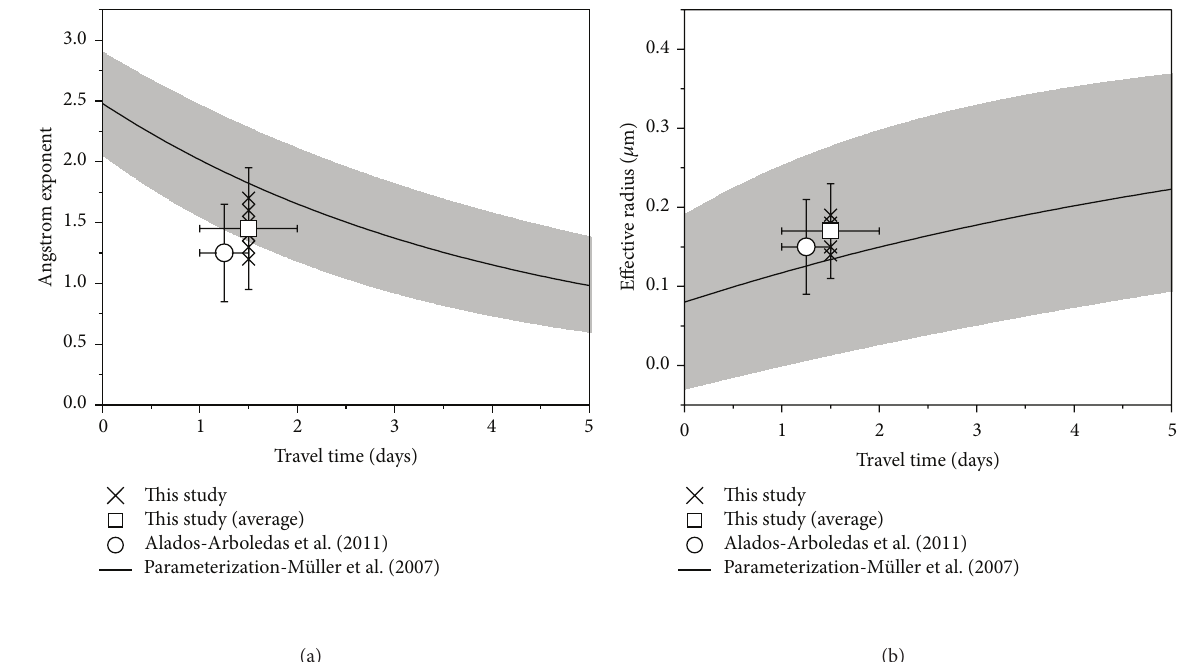
Figure 8: Extinction-related ˚Angstr¨om exponent and effective radius of forest fires smoke, based on Raman lidar measurements versus transport time. The results from the different cases measured at ´Evora are shown (crosses) as well as the average values (open squares). The average values from Alados-Arboledas et al. [27] are also shown (circles). The thick lines denote the first-order exponential fitting curves and the shaded areas represent the possible ranges for the parameterization according to the fitting parameters and respective fitting errors from M¨uller et al.